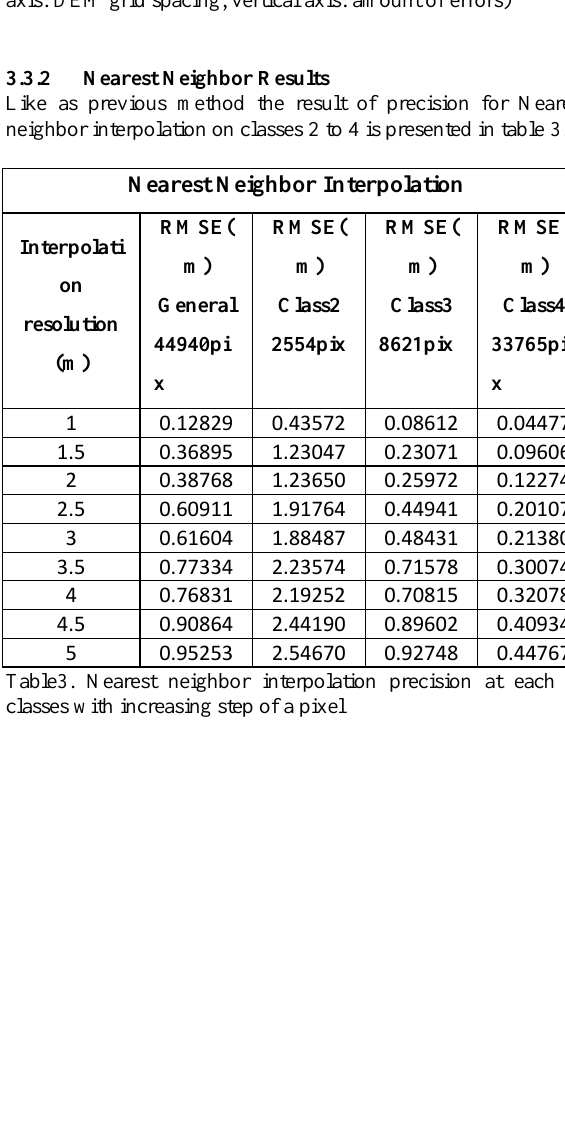
Figure10, Plots of precision changes in Nearest neighbor interpolation in each increasing step. Arrows show the maximum bound of reasonable relation between grid spacing and errors(Horizontal axis: DEM grid spacing, vertical axis: amount of